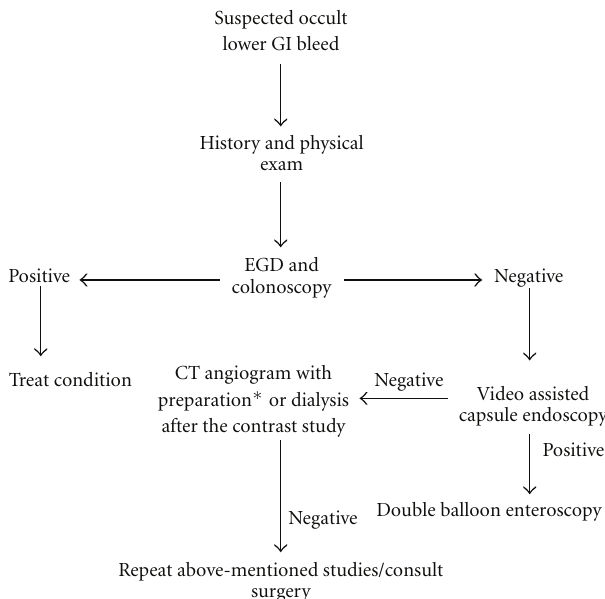
Figure 1: Algorithm to diagnose LGI bleed in CKD patients. ∗ Prepare with normal saline, bicarbonate drip, and acetylcysteine.